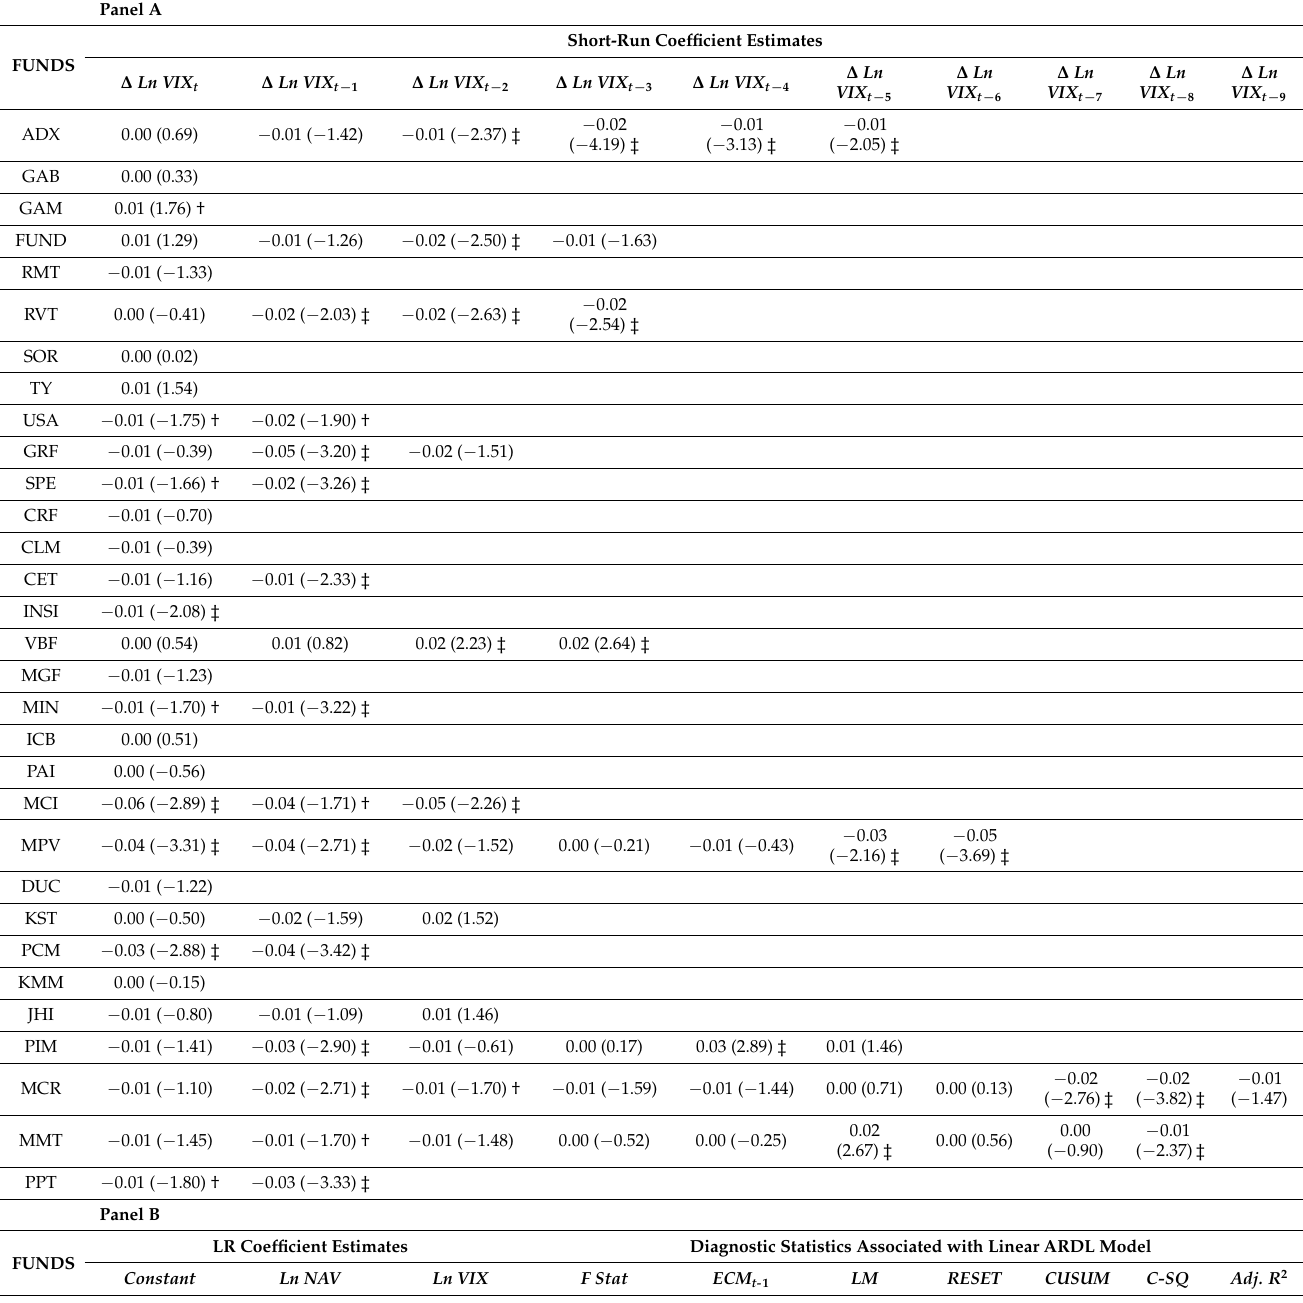
Table 12. Short-Run Coefficient Estimates—Linear ARDL—Model P = f (NAV,